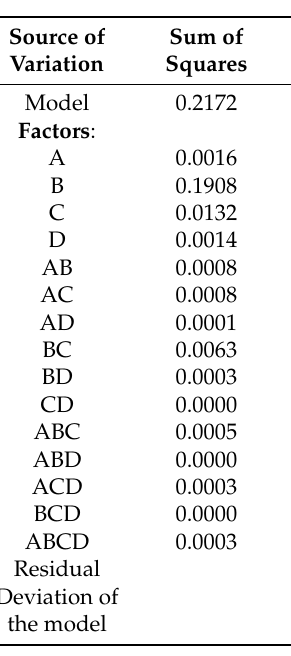
Table 6. ANOVA—Hybrid